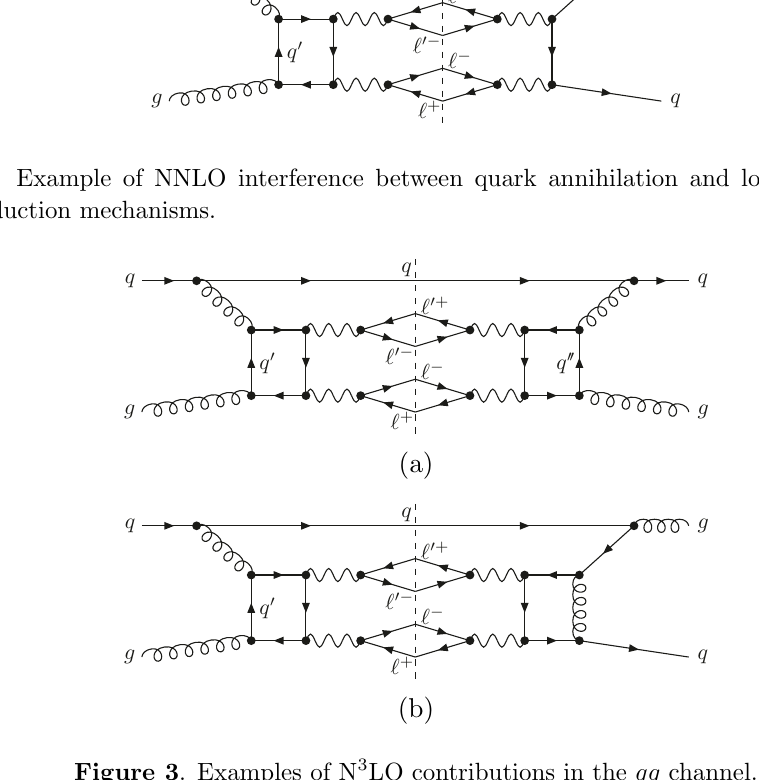
Figure 3 . Examples of N 3 LO contributions in the qg